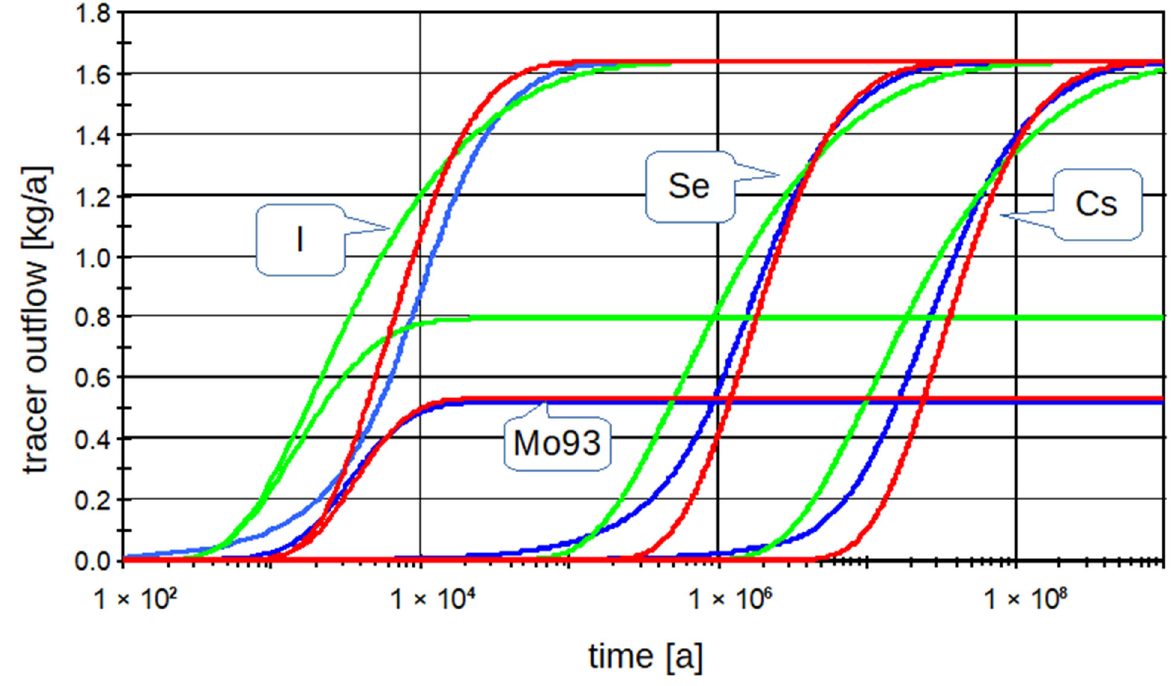
Figure 8. Comparison of outflows of tracers at site l3 according to Flow123d (blue curves), according to the three cascade “Pipe” components set from postprocessing data of the non ‐ sorbing tracer (green curves), and according to the optimized cascade of the three “Pipe” components (red curves).